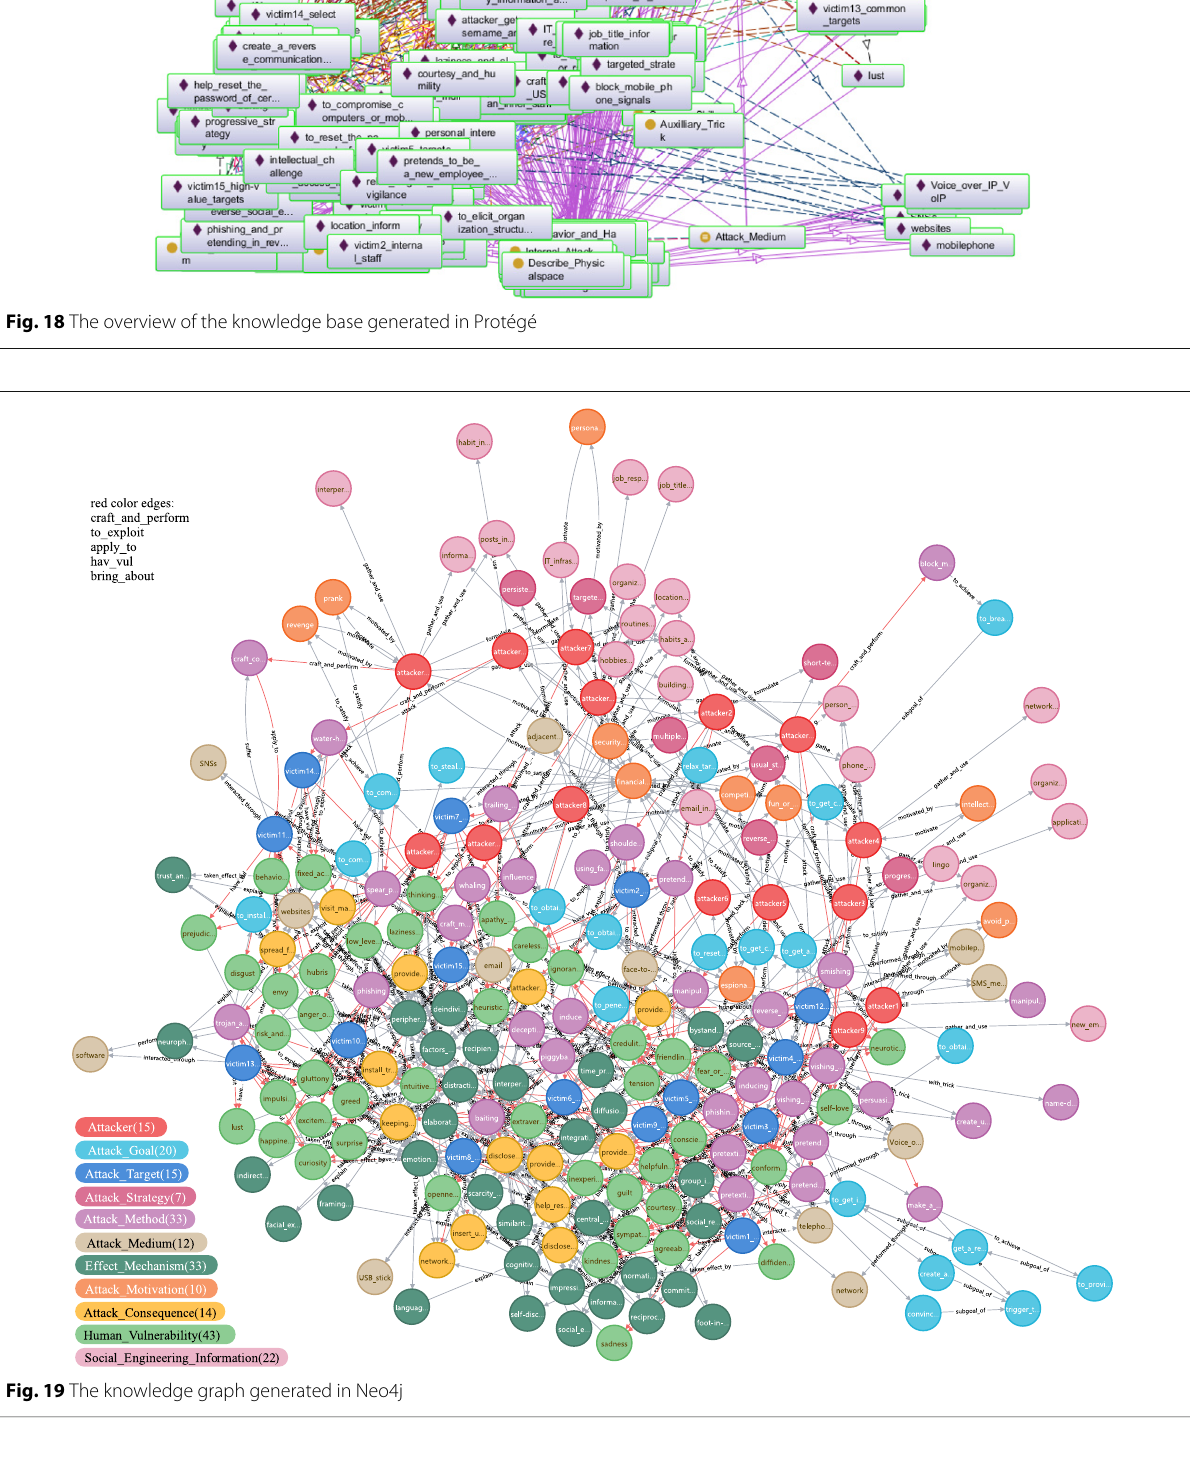
Fig. 19 The knowledge graph generated in